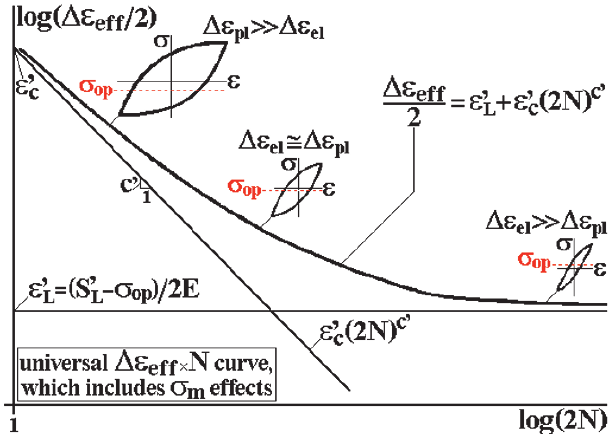
Figure 3: Universal  eff  N curve, which describes fatigue lives under any mean